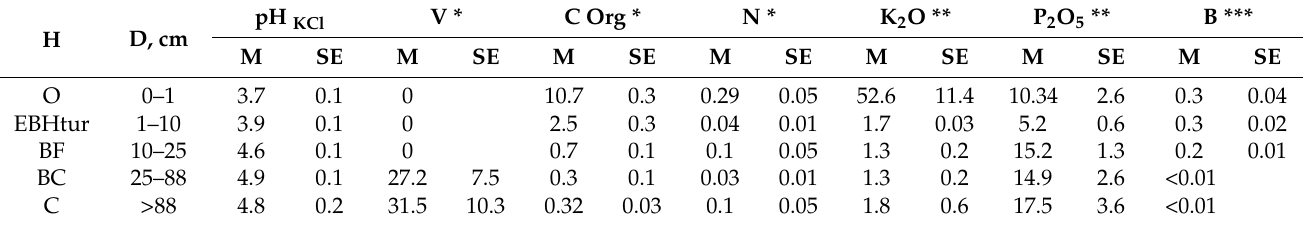
Table 2. Physicochemical soil properties of the plots before